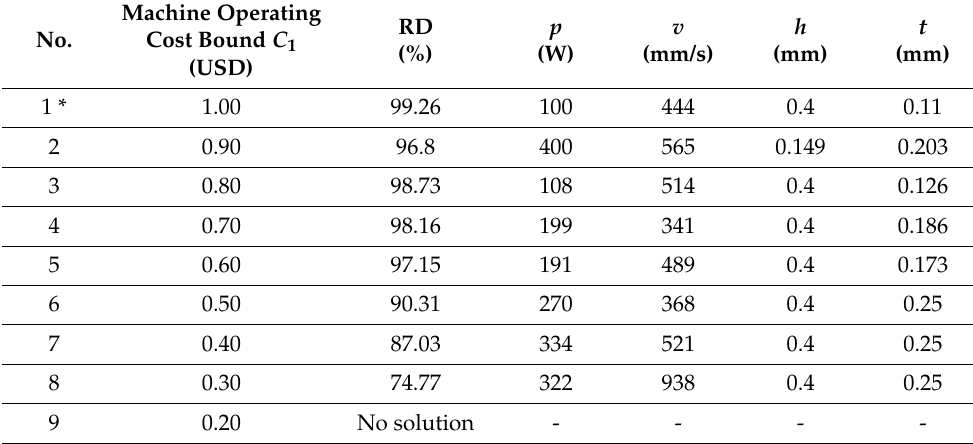
Table 4. Optimization results of Model 1 for different cost bounds ( C 1